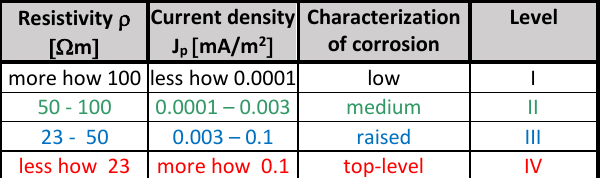
Table 1. The review according to ČSN 03 8372